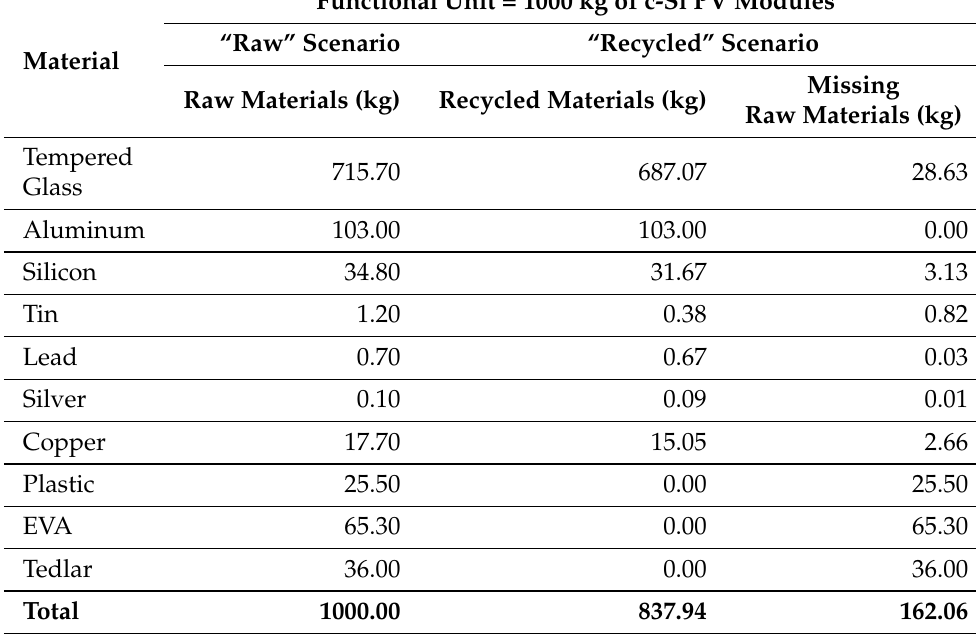
Table 3. Material flows in the PV manufacturing